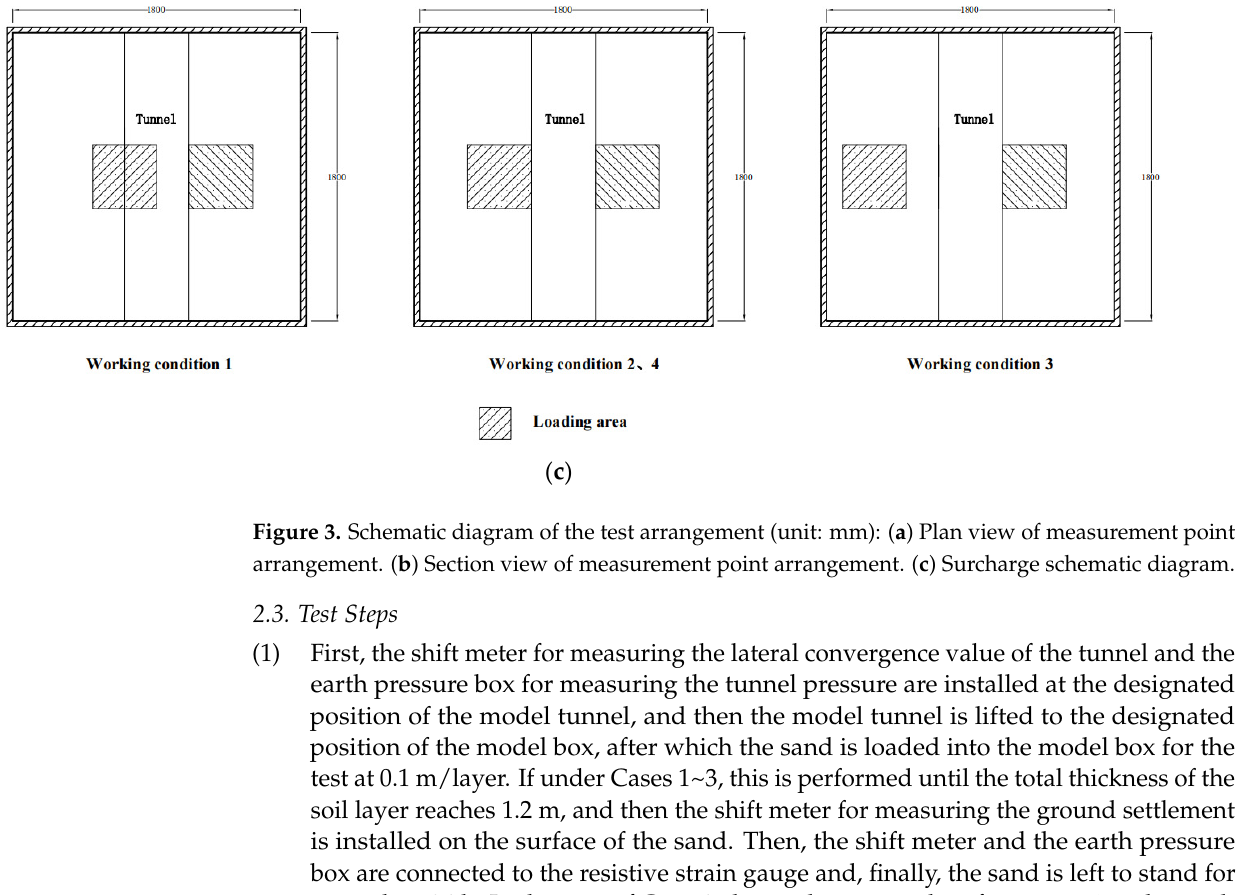
Figure 3. Schematic diagram of the test arrangement (unit: mm): ( a ) Plan view of measurement point arrangement. ( b ) Section view of measurement point arrangement. ( c ) Surcharge schematic diagram.